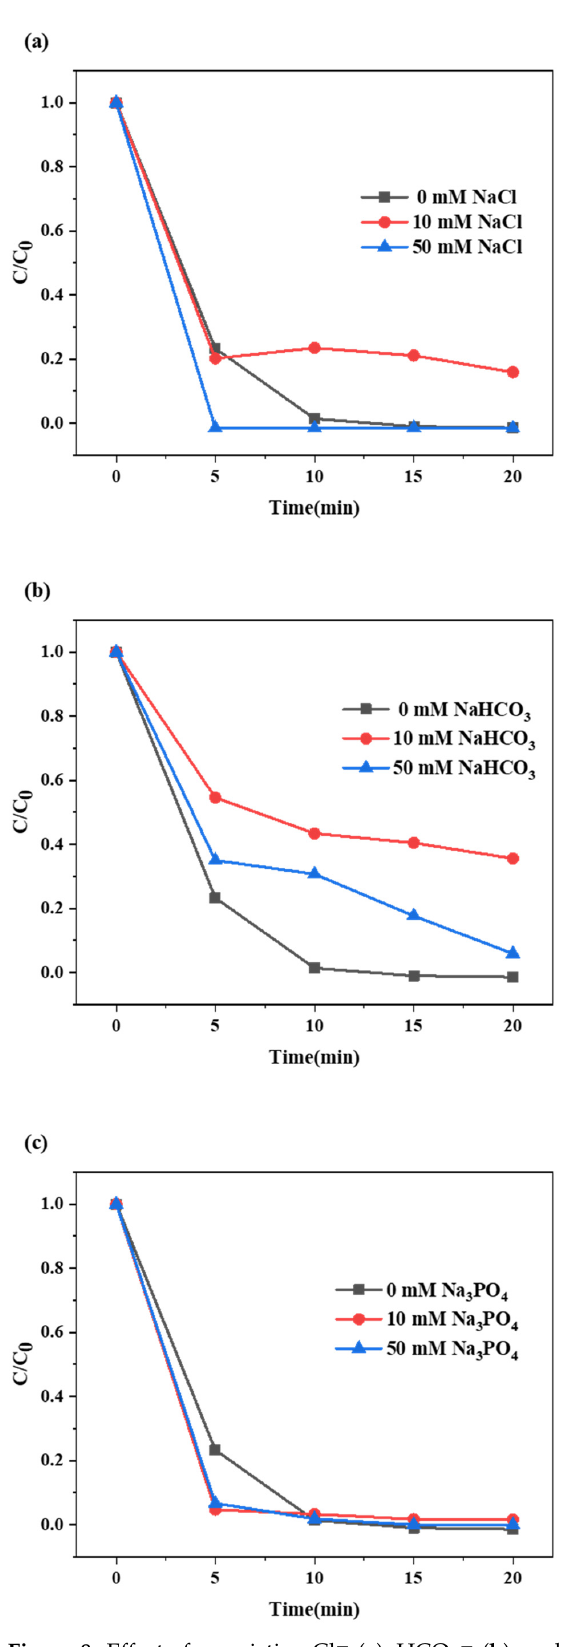
Figure 8. Effect of co-existing Cl − ( a ), HCO 3 − ( b ), and PO 4 3 − ( c ) on OG degradation. Condition: [OG] = 50 g/L, [PMS] = 3 mM, [ZVC] = 0.3